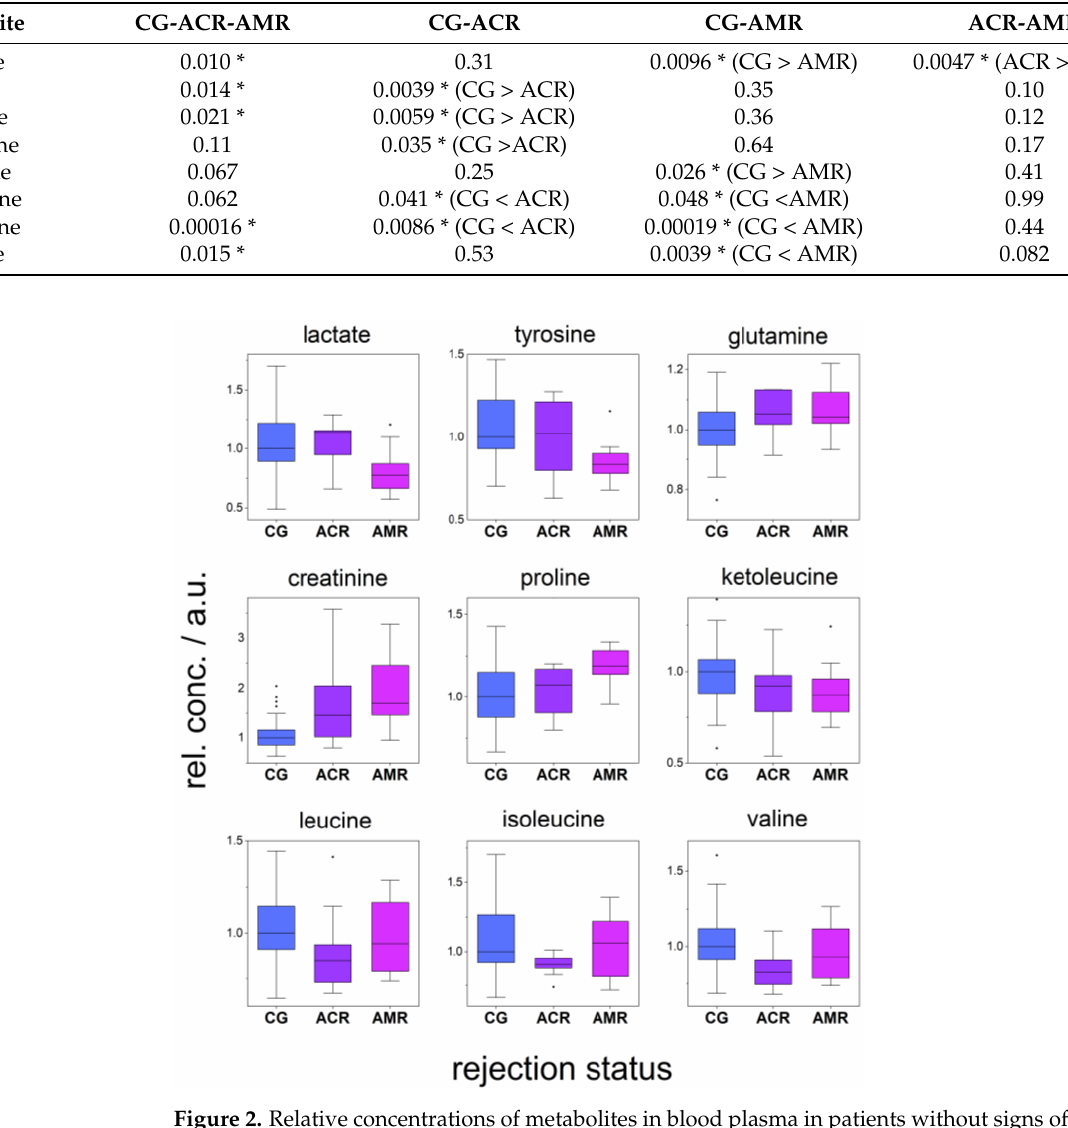
Figure 2. Relative concentrations of metabolites in blood plasma in patients without signs of rejection (CG), with acute cellular rejection (ACR), and acute antibody-mediated rejection (AMR).